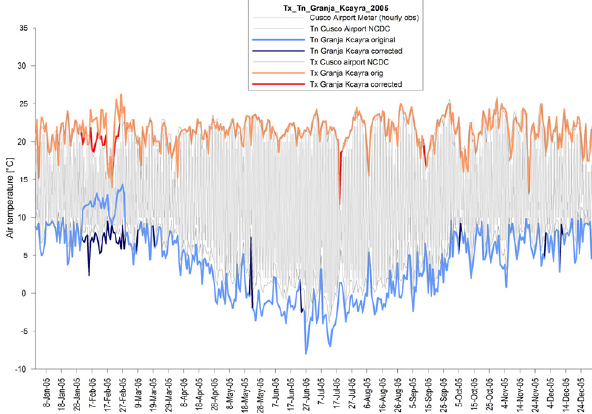
Figure 8. Comparison between daily minimum (Tn, in light blue) and maximum Temperature (Tx, in orange) of Granja Kcayra sta- tion (13.56 ◦ S, 71.88 ◦ W, 3219ma.s.l., near Cusco city), hourly METAR air temperature observations (in light grey) and NCDC Tx and Tn data records of the nearby station of Cusco-Airport (13.56 ◦ S, 71.88 ◦ W, 3219ma.s.l., in grey), and the respective cor- rections made for Granja Kcayra (in dark red and dark blue) for the year 2005.